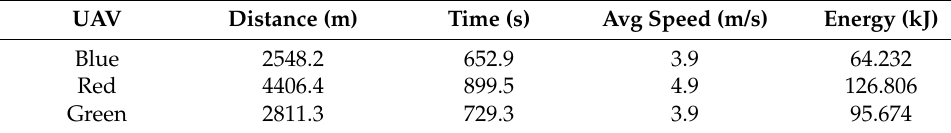
Figure 11. Flight profile for the UAV in green in Figure 9. Table 2. Statistics for the Paths Shown in Figure 10.